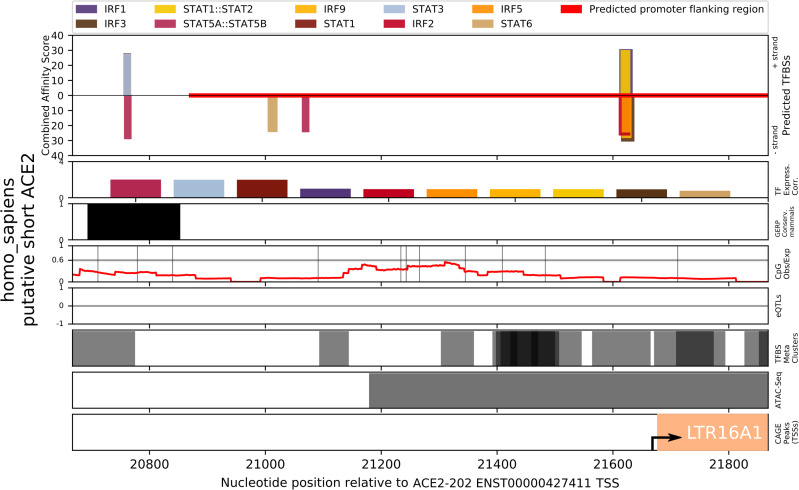
Prediction of interferon-stimulation mediating transcription factor binding sites in the promoter region of the putative short-form of human ACE2 gene using TFBSfootprinter.The long terminal repeat 16A1 (LTR16A1) is cataloged in the FANTOM dataset [36] and has been identified as potentially relevant for interferon-mediated transcription of this new ACE2 transcript [56]; it is displayed in the CAGE peaks track along with an arrow indicating the TSS. The region analyzed represents –1,000 bp to +200 bp relative to the putative TSS, while nucleotide positions at bottom are given relative to the ACE2 full length transcript.